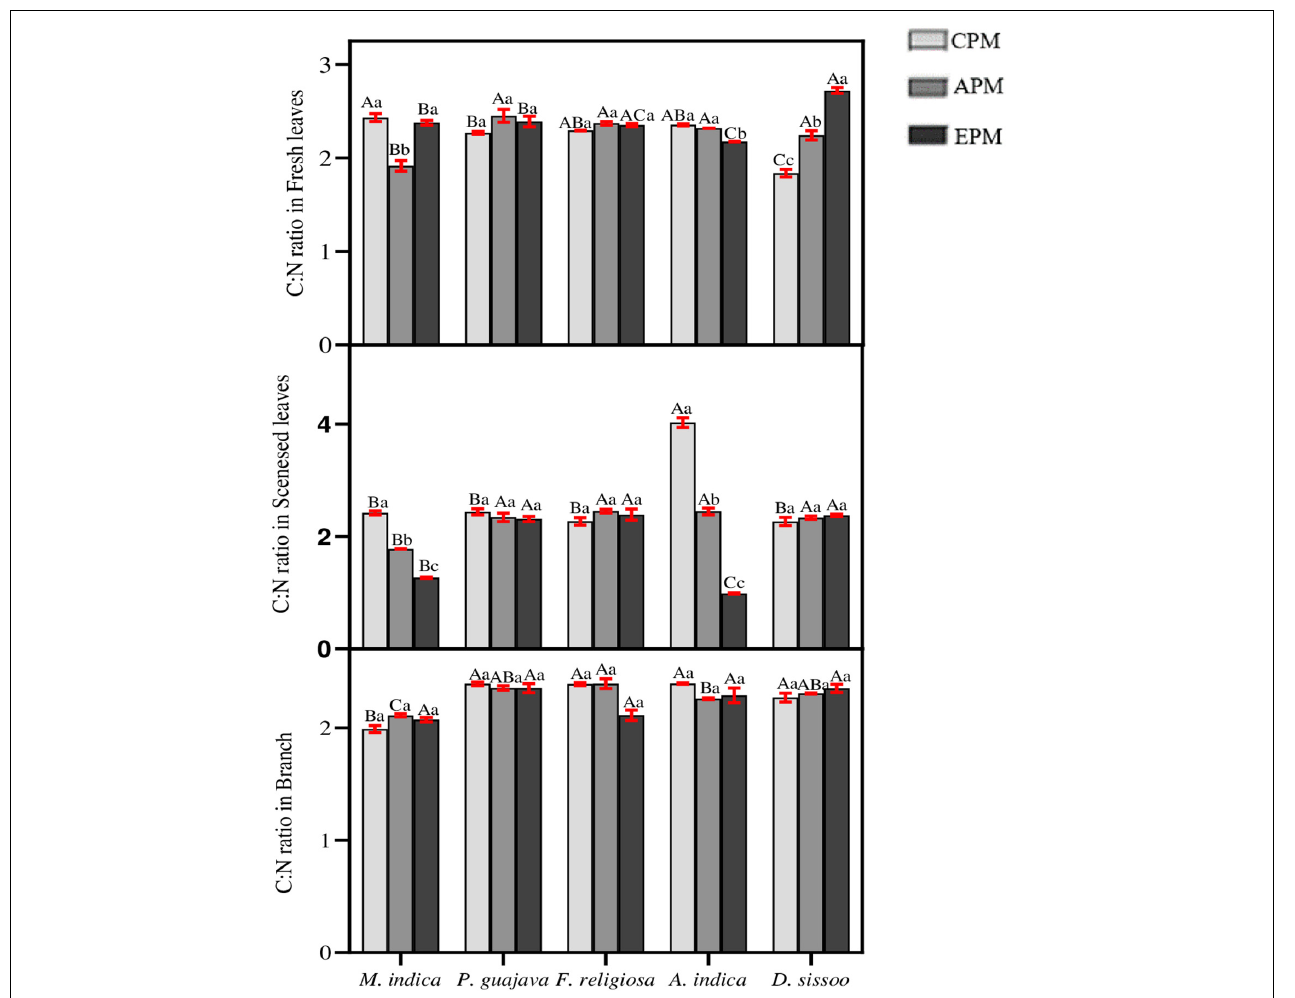
FIGURE 6 | The nutrient stoichiometry of C and N for different tree species under different PM treatments. Different letters in uppercase indicate a significant difference between PM treatments for different trees ( p < 0.05) and different lowercase letters indicate a significant difference between the treatment with species ( p <